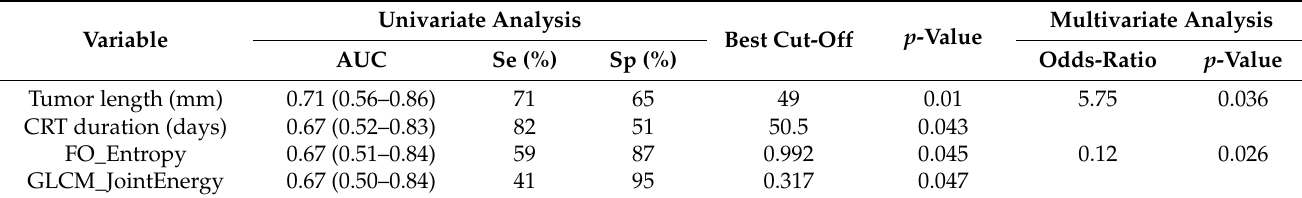
Table 3. Correlation between variables and 2-year disease recurrence. (Abbreviations: Se = sensitivity, Sp = specificity).